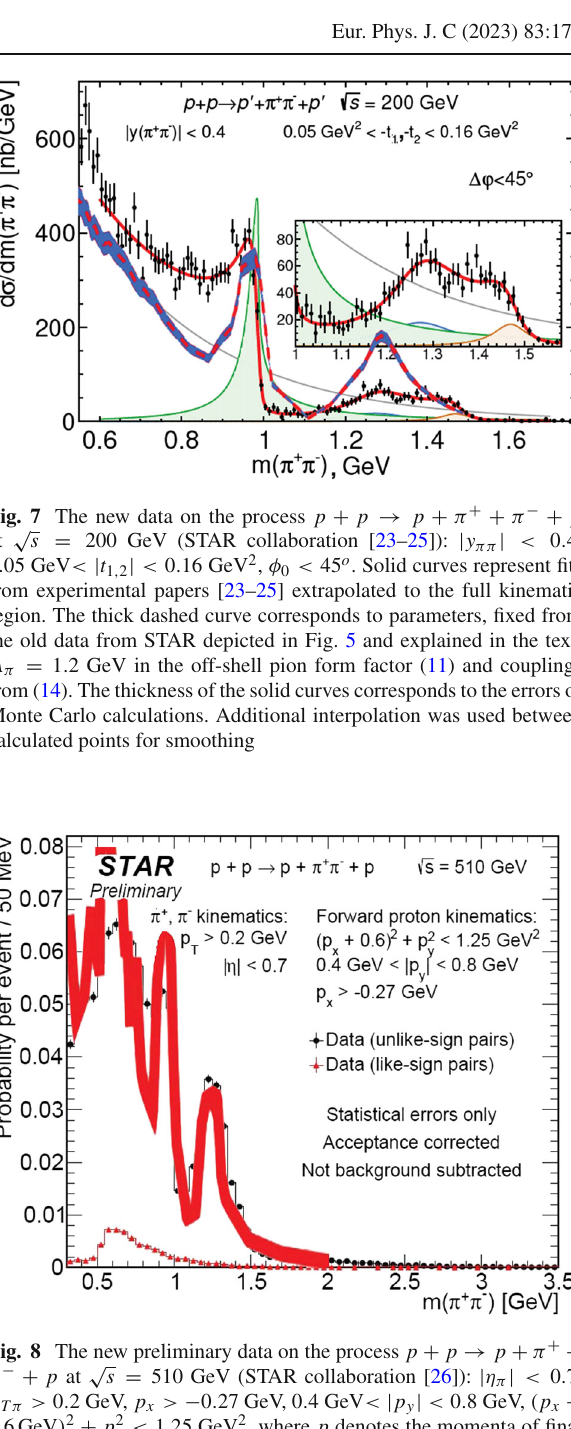
Fig. 6 Thenewdataontheprocess p + p → p + π + + π − + p at 200 GeV (STAR collaboration [23–25]): | η π | < 0 . 7, p T π > 0 . 2 GeV, p x > − 0 . 2 GeV, 0 . 2 GeV < | p y | < 0 . 4 GeV, ( p x + 0 . 3GeV ) 2 + p 2 y < 0 . 25 GeV 2 , where p denotes the momenta of final protons. Curves correspond to Λ π = 1 . 2 GeV in the off-shell pion form factor (11) and couplings from (14). Solid curves correspond to the sum of all amplitudes, and the dashed lower curve in a represents the continuum contribution. The thickness of the solid curves corresponds to the errors ofMonteCarlocalculations.Additionalinterpolationwasusedbetween calculated points for smoothing